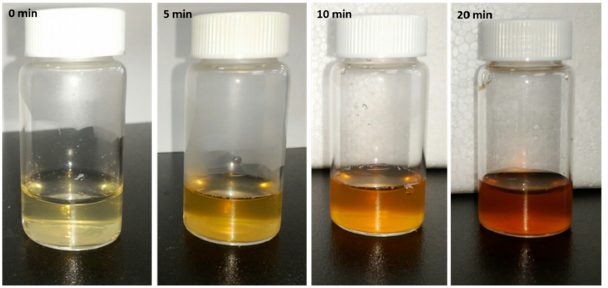
Figure 1. Time dependent variations in the colour of colloidal solution of silver nanoparticles synthesized using aqueous extract of Coptidis rhizome.